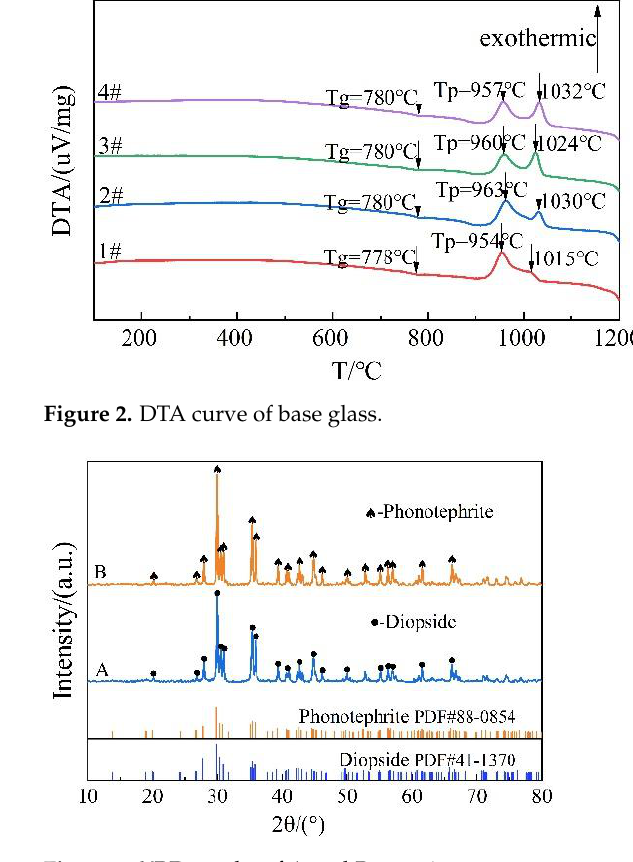
Figure 3. XRD results of A and B experiments.